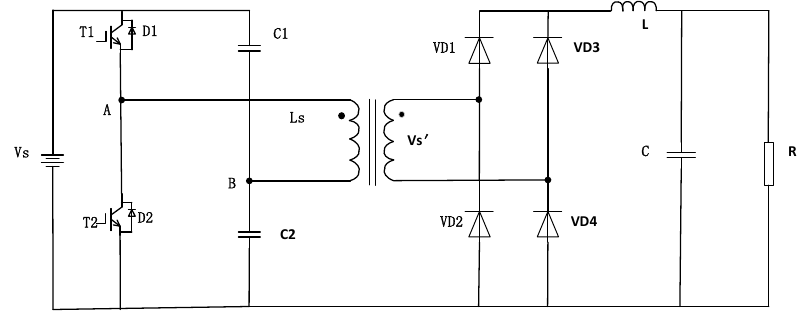
Figure 2. Circuit diagram of half bridge DC/DC converter.